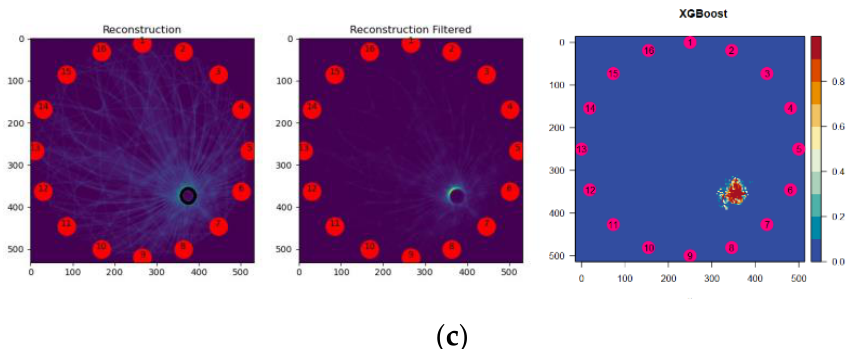
Figure 10. Each reconstructed object is labelled on the left graph, the filtered reconstruction obtained by the deterministic method is shown in the middle, and the reconstruction using the XGBoost model is shown on the right: ( a ) Cylinder of 10 mm diameter placed in the centre of the tank; ( b ) cylinder of 30 mm diameter placed in the centre of the tank; ( c ) cylinder of 30 mm diameter placed in the half from the centre to the tank bound (rotated through a 45-degree angle).